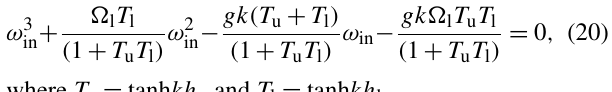
= 0 . 1565 ,U ∗ = 0 ,h u /h = 1 / 3 ,ρ u /ρ = 0 . 95, l l √ l b = 0 . 01 h u , a = 0 . 1 H , and T = 512. U has been non-dimensionalized with gH , where i b 1 /(cid:49)T